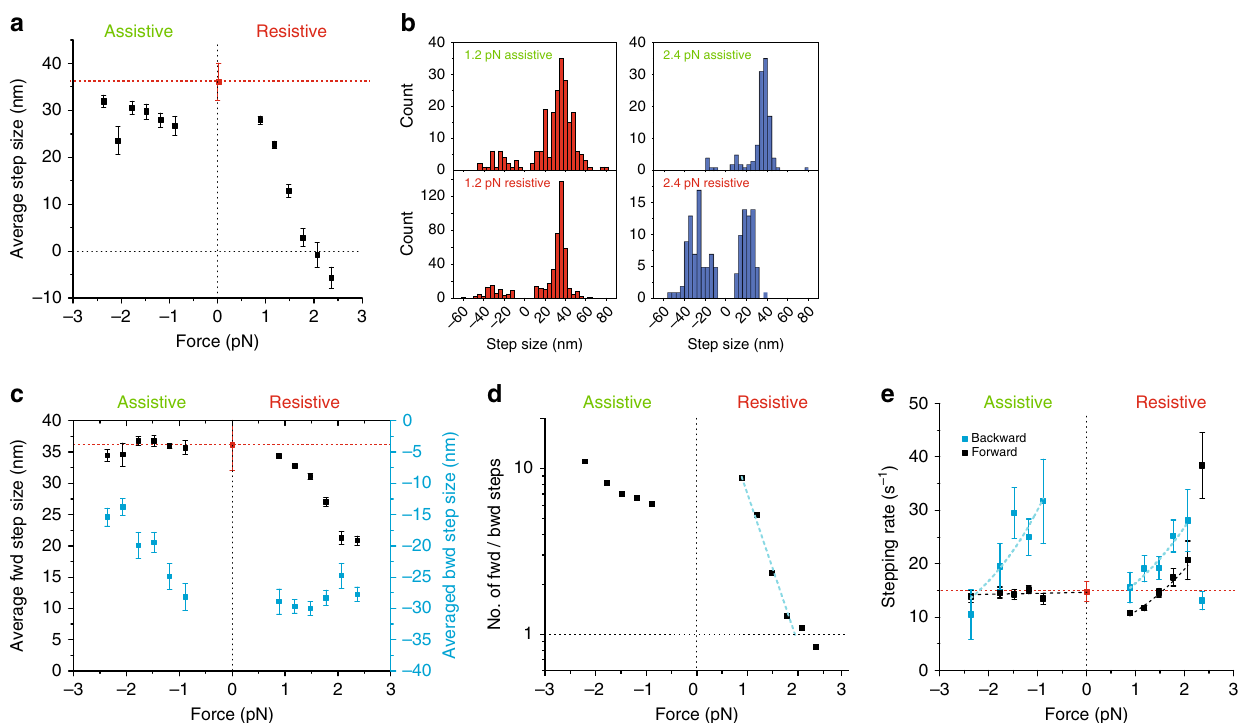
Fig. 5 The ratio of forward to backward steps determines myosin-5B run length and velocity under resistive load. a Force dependence of the average step size. Box plot in Supplementary Fig. 1c. b Step size distributions at ±1.2 pN (left panel) and ±2.4 pN (right panel). For resistive forces close to the stall force ( + 2.4 pN), the distributions of forward (>0) and backward (<0) steps become nearly symmetric. c Force dependence of the average forward (black squares) and backward (cyan squares) step size. d Force dependence of the ratio of forward to backward steps. The dotted cyan line is the fi t of the e Force dependence of forward (black squares) and backward (cyan squares) stepping rates. Exponential fi ts k f ; b ¼ k ± backward ( b ) stepping rates for positive ( + ) and negative ( − ) forces gave: k þ dotted lines in a – c and e are, respectively, the unloaded step size and stepping rate measured with the single molecule motility assay at [ATP] = 100 μ